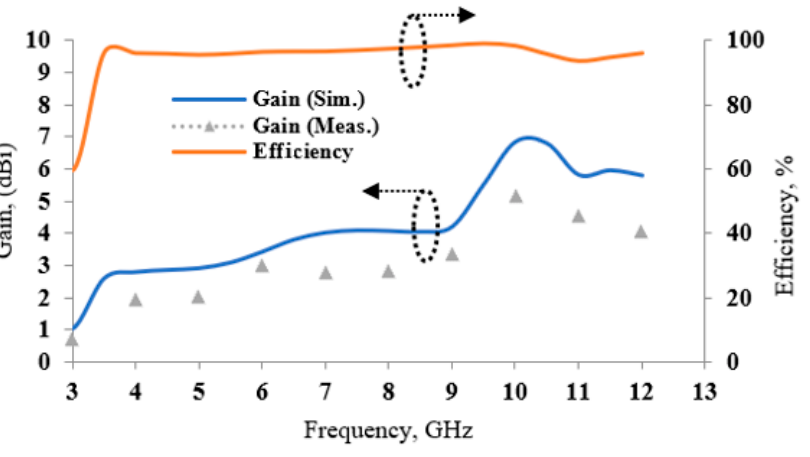
Figure 5. Gain and efficiency of the proposed UWB antenna.